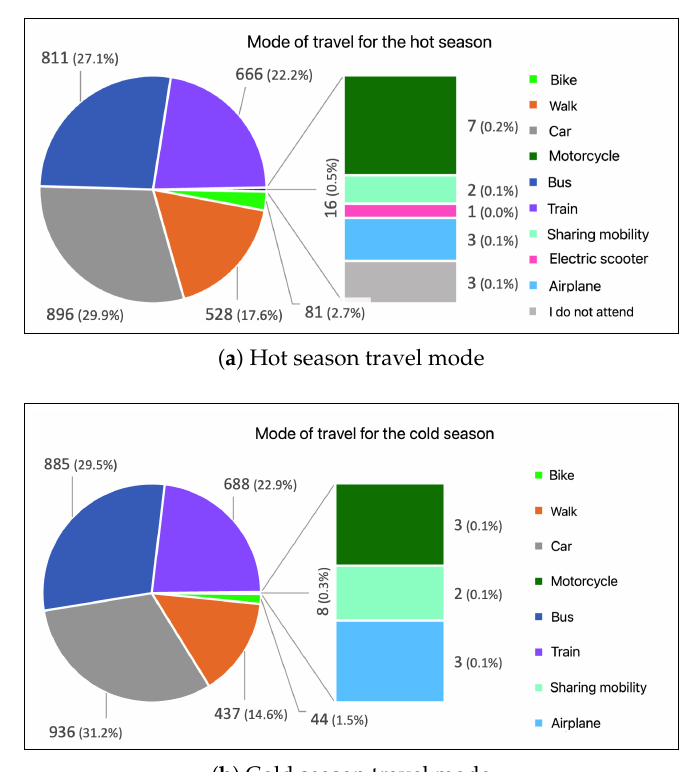
Figure 14. Travel mode in different